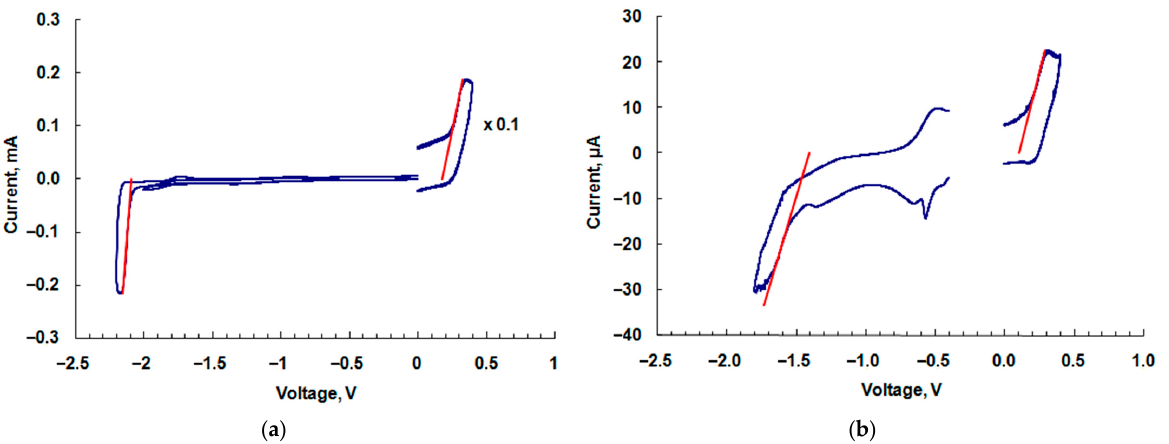
PVK are available in reference [13].